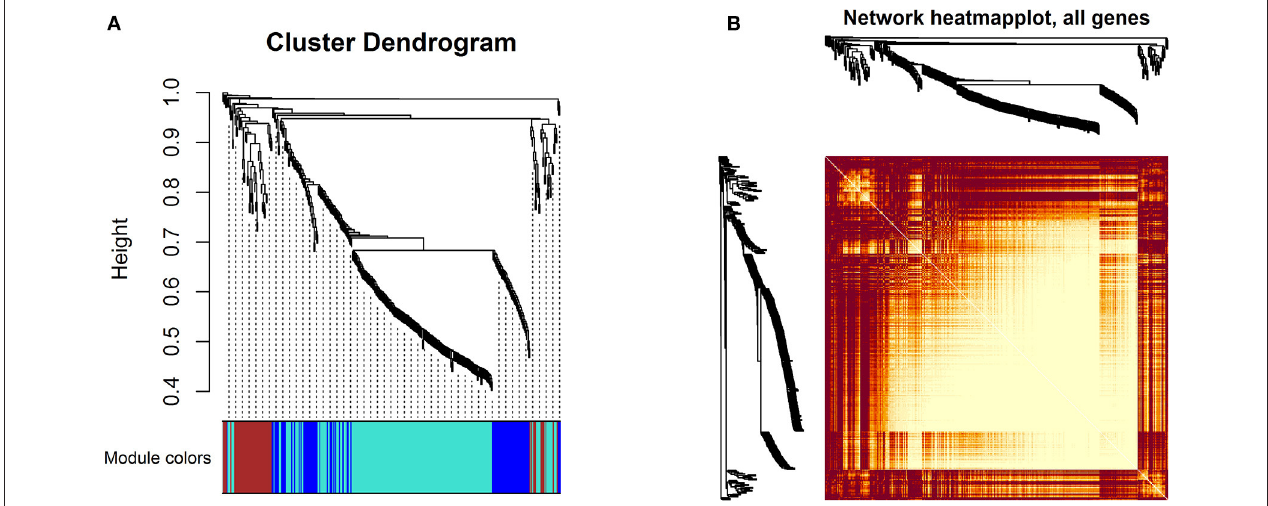
FIGURE 6 | WGCNA: (A) Cluster dendrogram of the common genes. The branches and color bands demonstrate the specific module. (B) TOM plot; light color symbolizes low overlap, and progressively darker red color symbolizes higher overlap between common genes. Blocks of darker colors along the diagonal correspond to